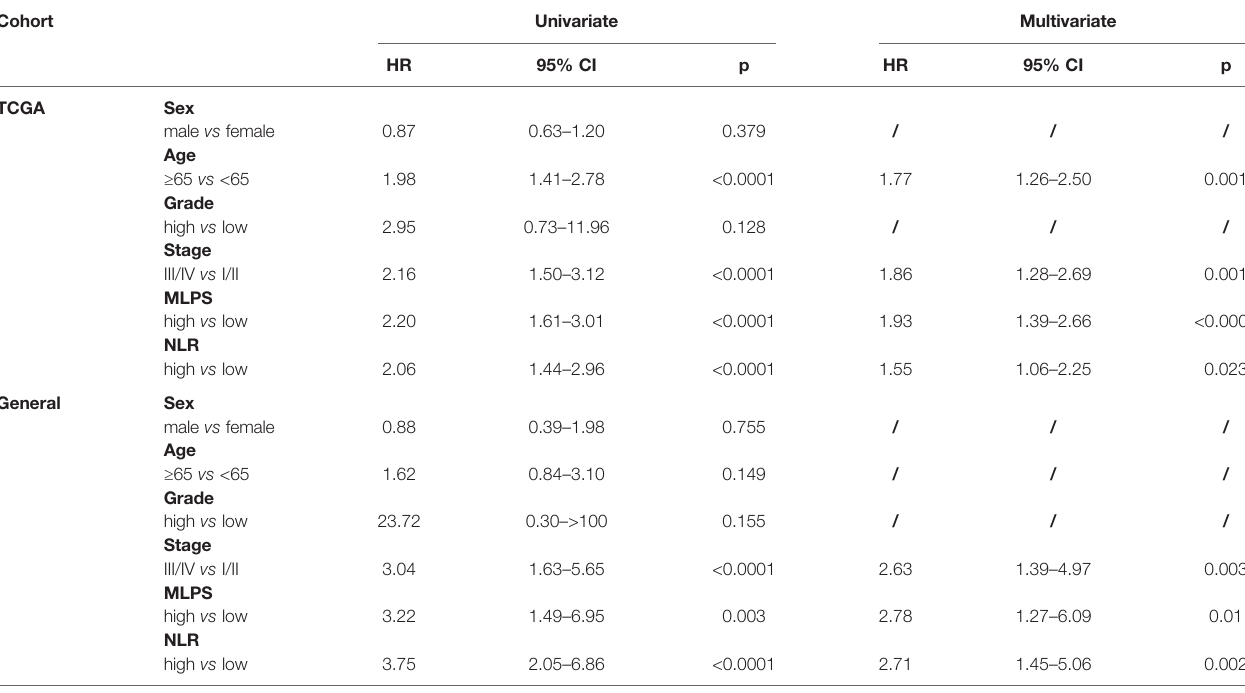
TABLE 2 | Univariate and multivariate cox regression analysis of prognostic markers two independent patient cohorts. Cohort Univariate Multivariate HR 95%